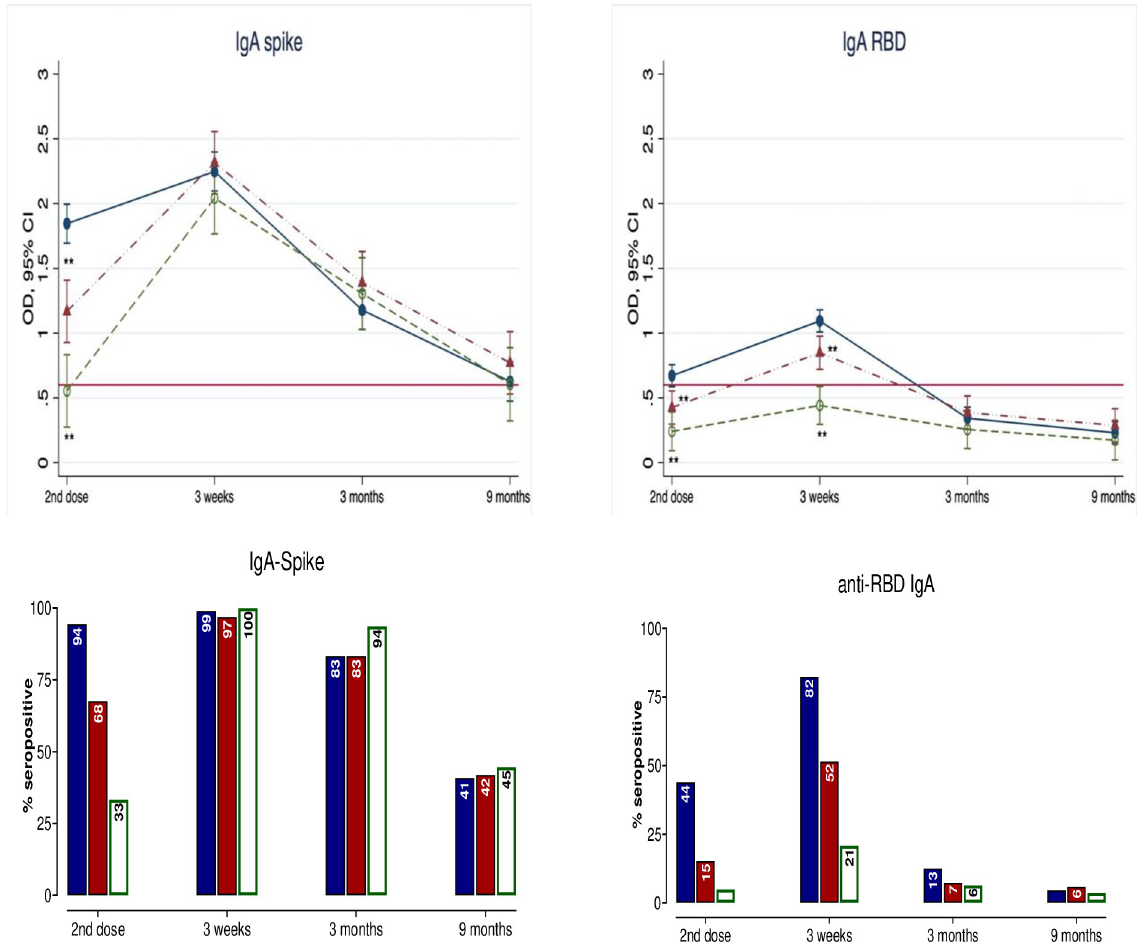
Fig 3. Mean titers and seropositivity rates for IgA to ancestral SARS-CoV-2 Spike and RBD by study visit and dosing interval. Upper panel: Serum IgA titers to ancestral SARS-CoV-2 Spike and RBD measured in each group at the same time points post-2 nd dose using a validated ELISA (see METHODS). Data are expressed in optical density (OD) with 95% confidence interval (CI) and fully adjusted for age, sex, education, smoking, alcohol use, body-mass index, known comorbidities (cardiovascular, neoplastic, autoimmune, renal and chronic respiratory diseases) and the number of days after 2 nd vaccine dose to subsequent blood draw. The dosing interval groups 35-42-days (red symbols) and > 42-days (open green symbols), were compared to the < 35-days group (reference group, blue closed symbols). For the summary numerical data, please refer to S3 Appendix in S1 File. Interaction terms for visit x group were all significant at p < 0.0001. Therefore, between group comparisons ( < 35-day group as reference) were conducted with p-values � < 0.05 and �� < 0.005. The red solid line represents the assay’s threshold of detection (see S1 Appendix in S1 File for numerical values). Lower Panel: The bars represent the % of participants with seropositive IgA to ancestral SARS-CoV-2 Spike and RBD within each group by visit. Seropositivity was defined by titer levels above the assay’s threshold of